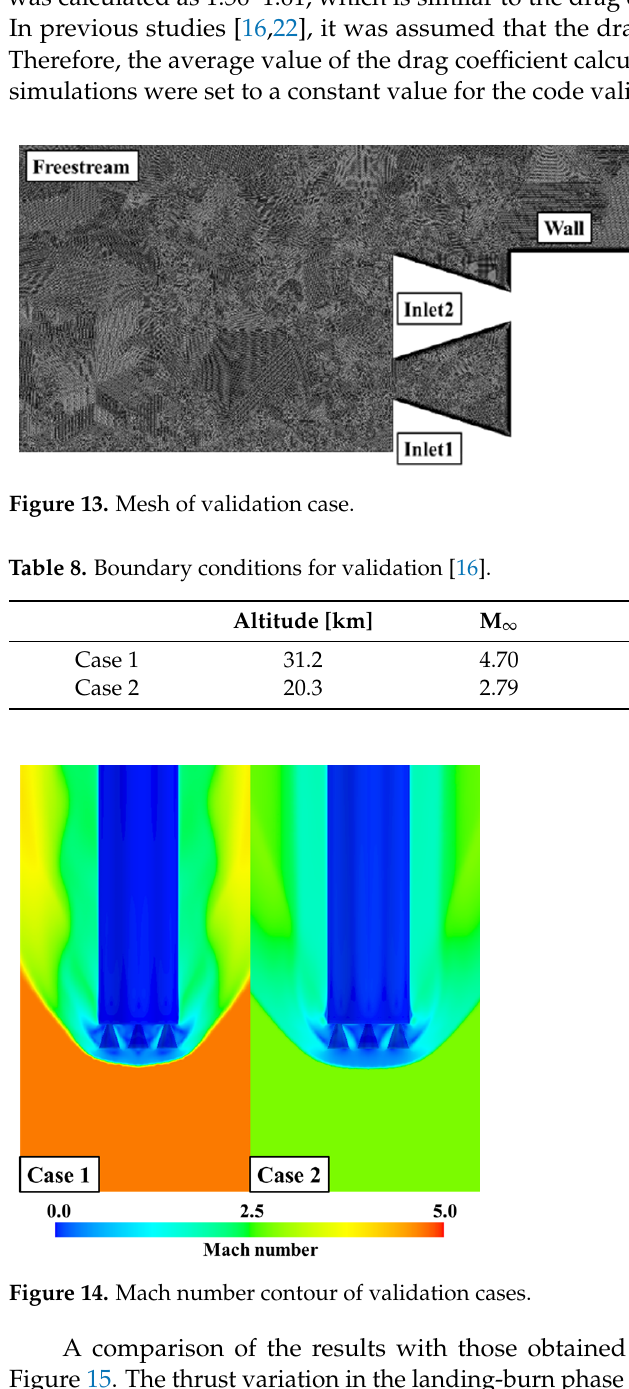
Table 8. Boundary conditions for validation [16].